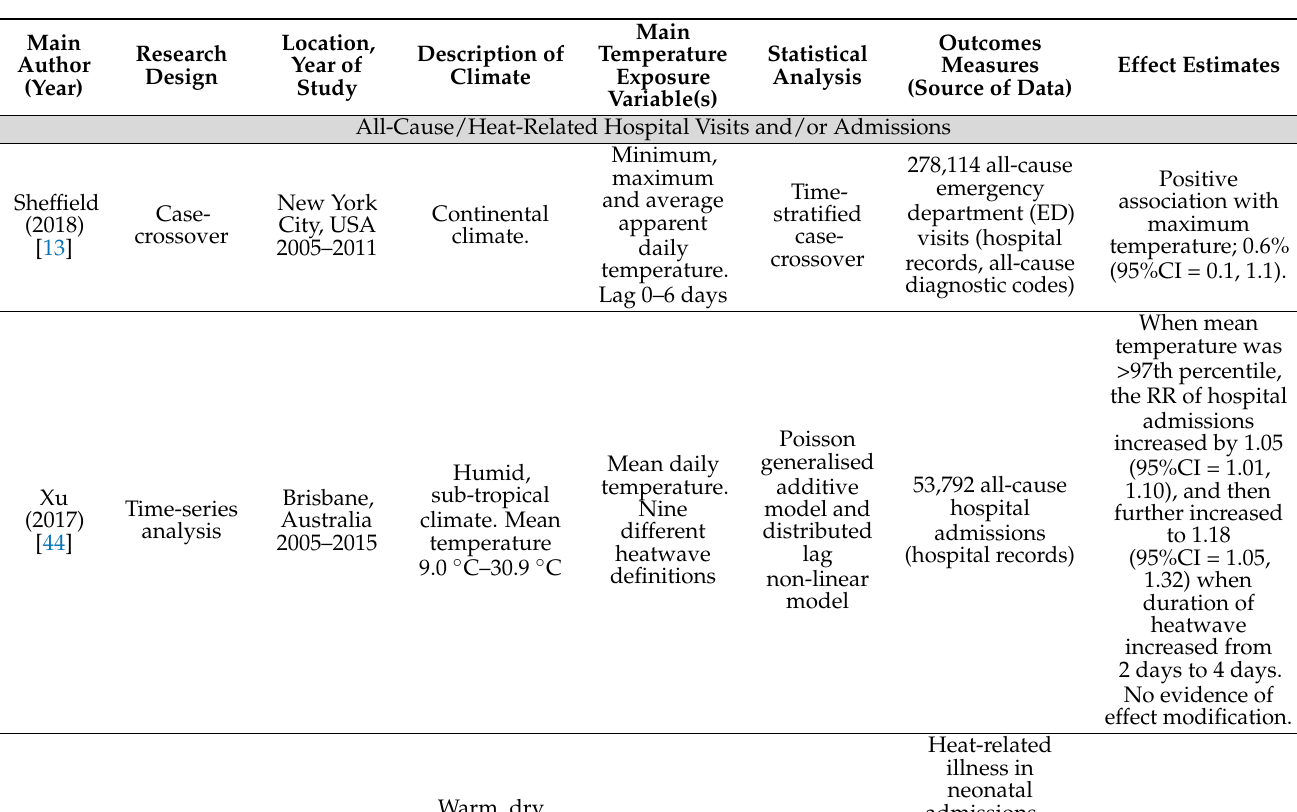
Table 3. Summary of the study findings that assess temperature effects on hospital visits/admissions, infectious diseases and other neonatal